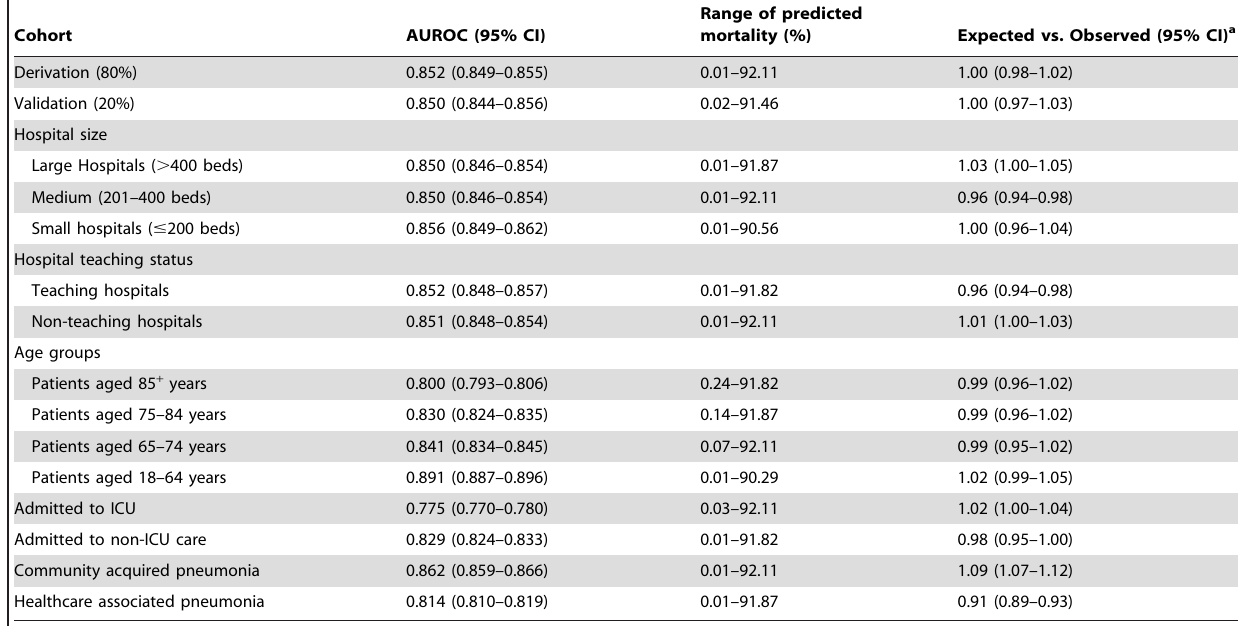
Table 2. Model Performance in Subpopulations of Entire